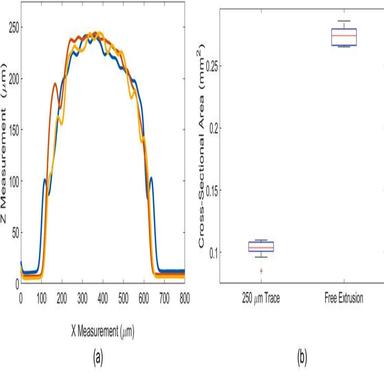
(a) Representative cross-sectional area scans of the rectilinear printed bead distanced 500 μm apart along the Y-axis of the print. (b) Calculated cross-sectional area of free extrusion and rectilinear printed samples.